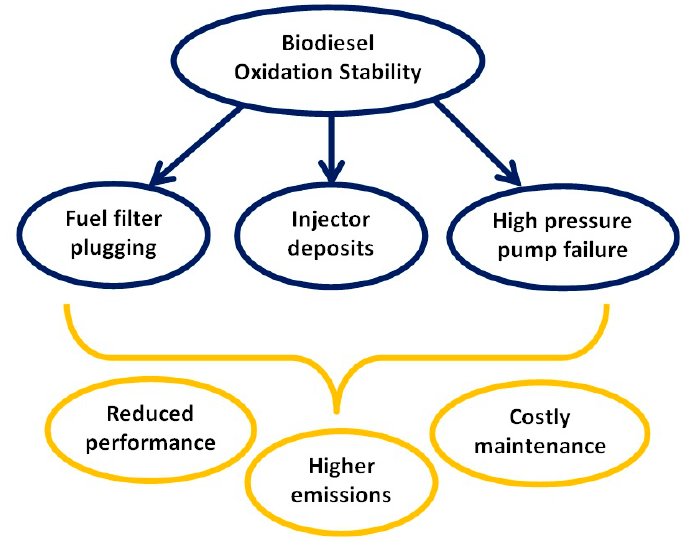
Figure 1. Effects of biodiesel oxidation stability problems on engine operation. Figure 1. E ff ects of biodiesel oxidation stability problems on engine